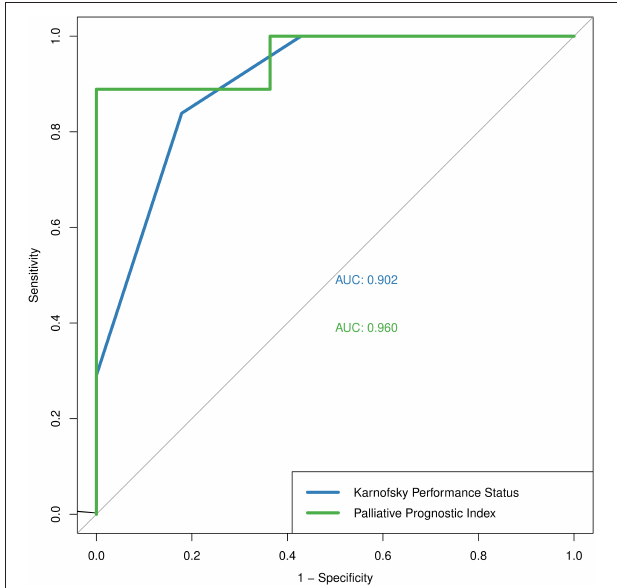
FIGURE 2 | The Receiver Operating Characteristic curve of Karnofsky Performance Status (blue) and Palliative Prognostic Index